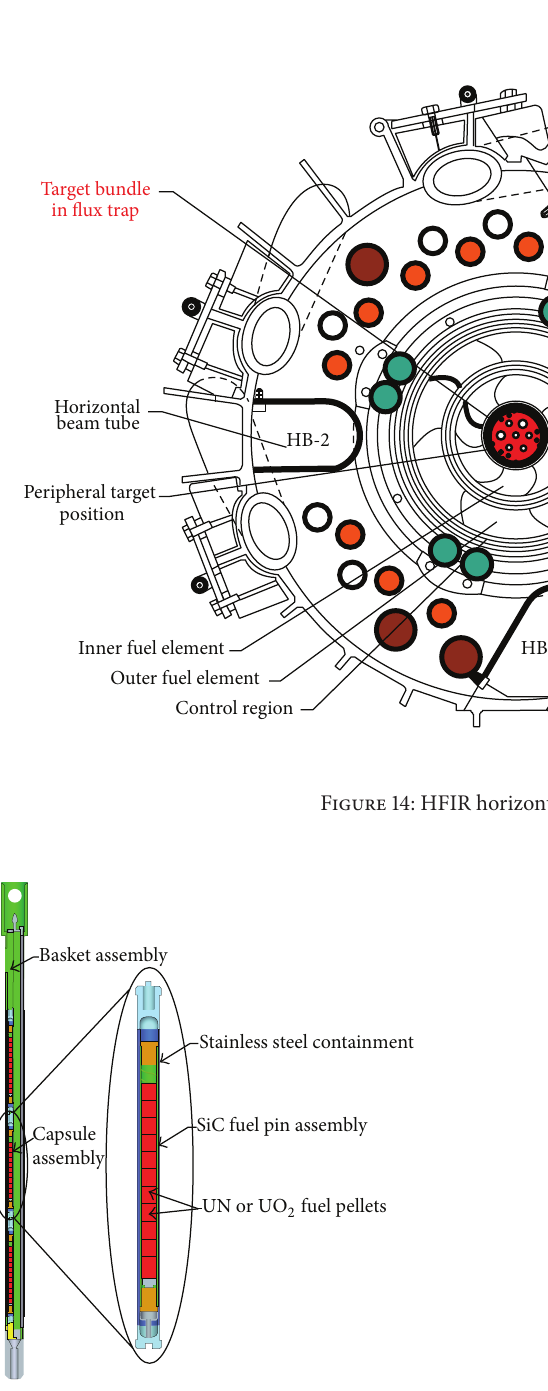
Figure 15: Vertical view of the thermal neutron irradiation facility with a close-up of one of the nine capsule assemblies [11].